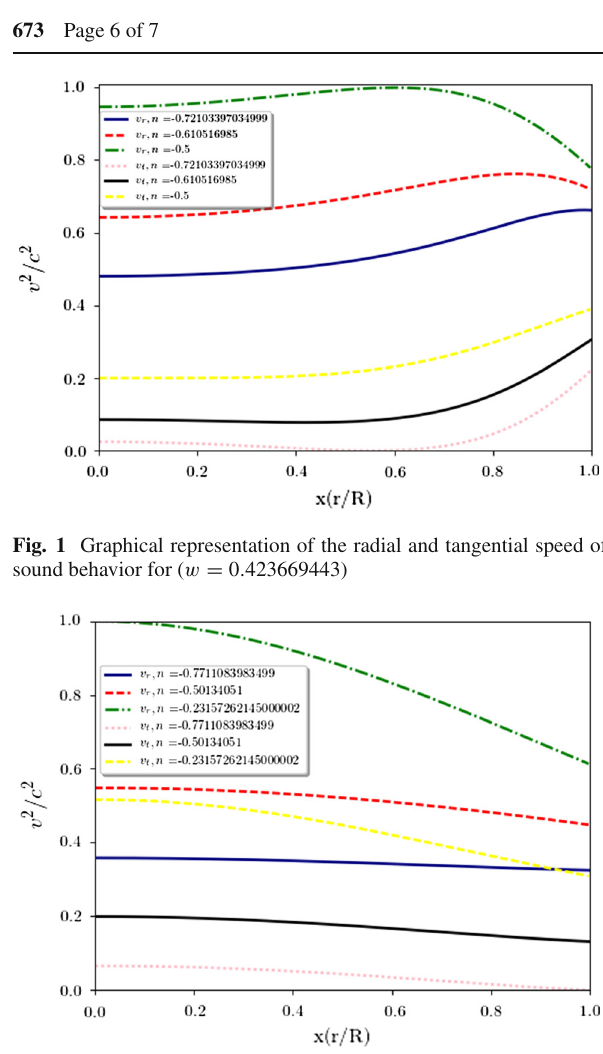
Fig. 2 Graphical representation of the radial and tangential speed of sound for w = 0 . 222